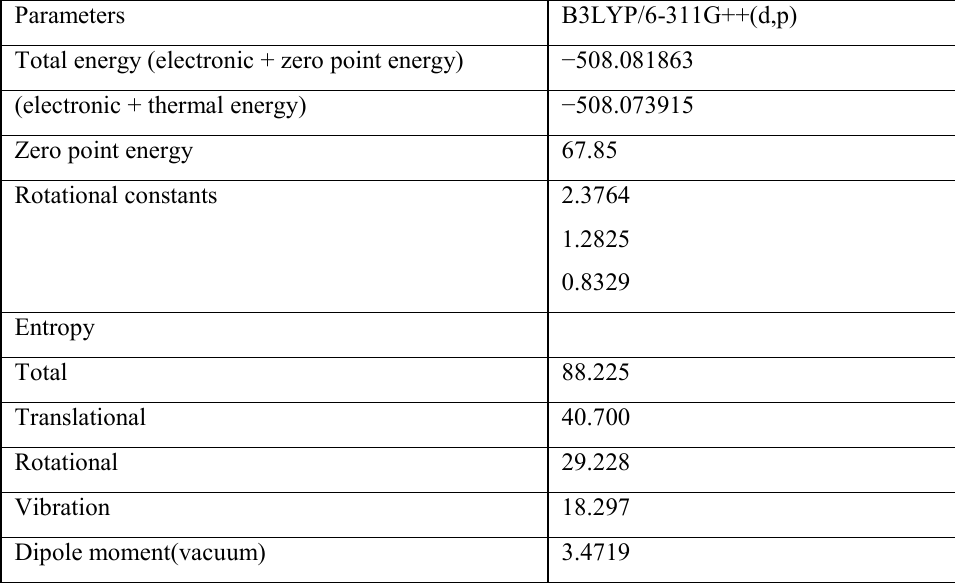
Table 7 . Theoretically calculated energies (a.u), zero point vibration energies (Kcal mol -1